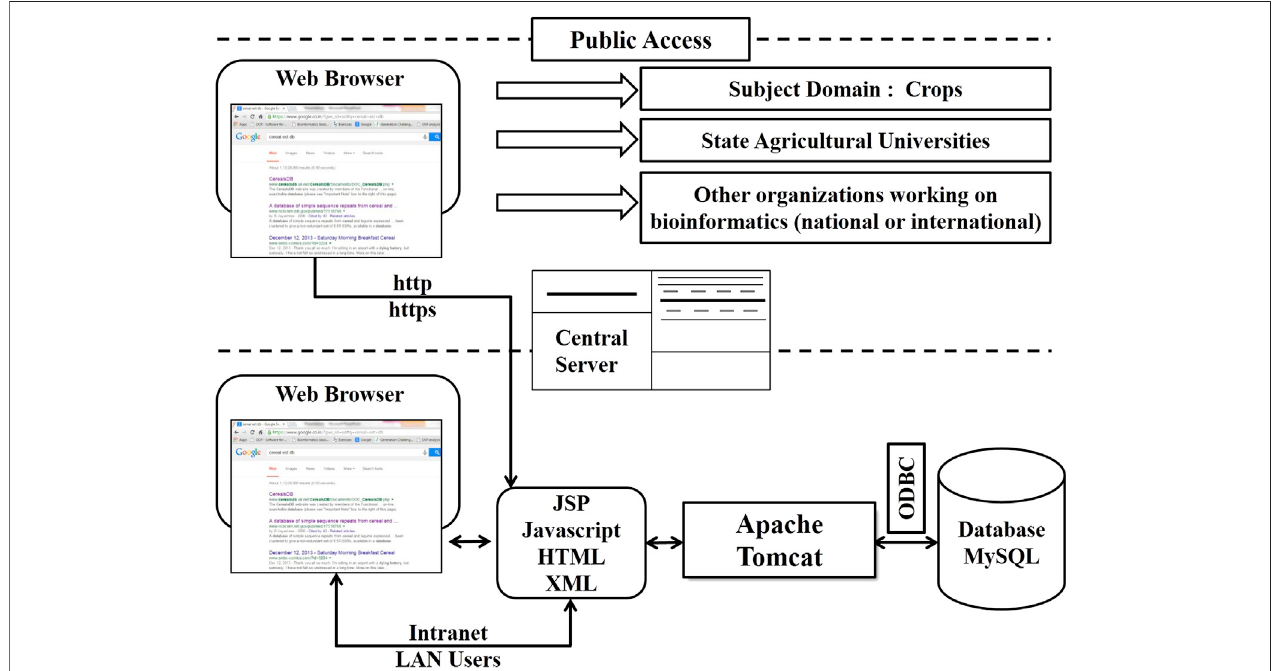
FIGURE 3 | Three-tier architecture of the software used in